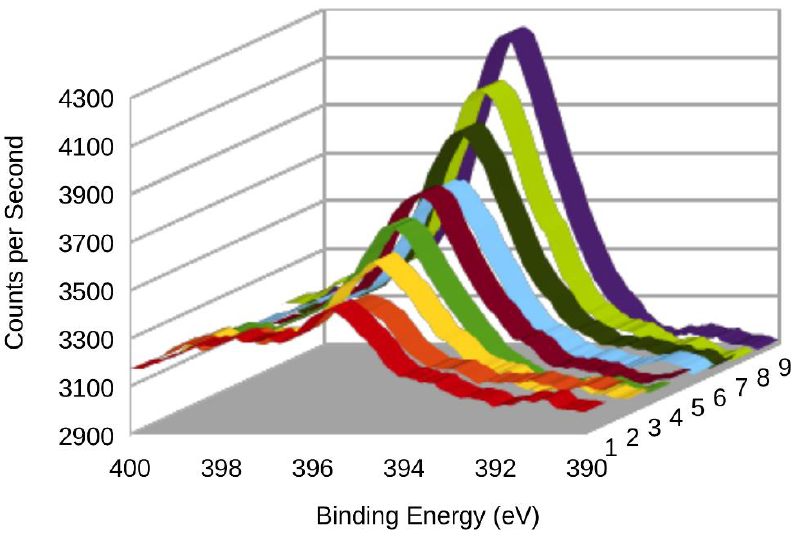
Figure 12. XPS depth profile (with smoothing) of the Ti N1s region of anodically altered titanium nitride.